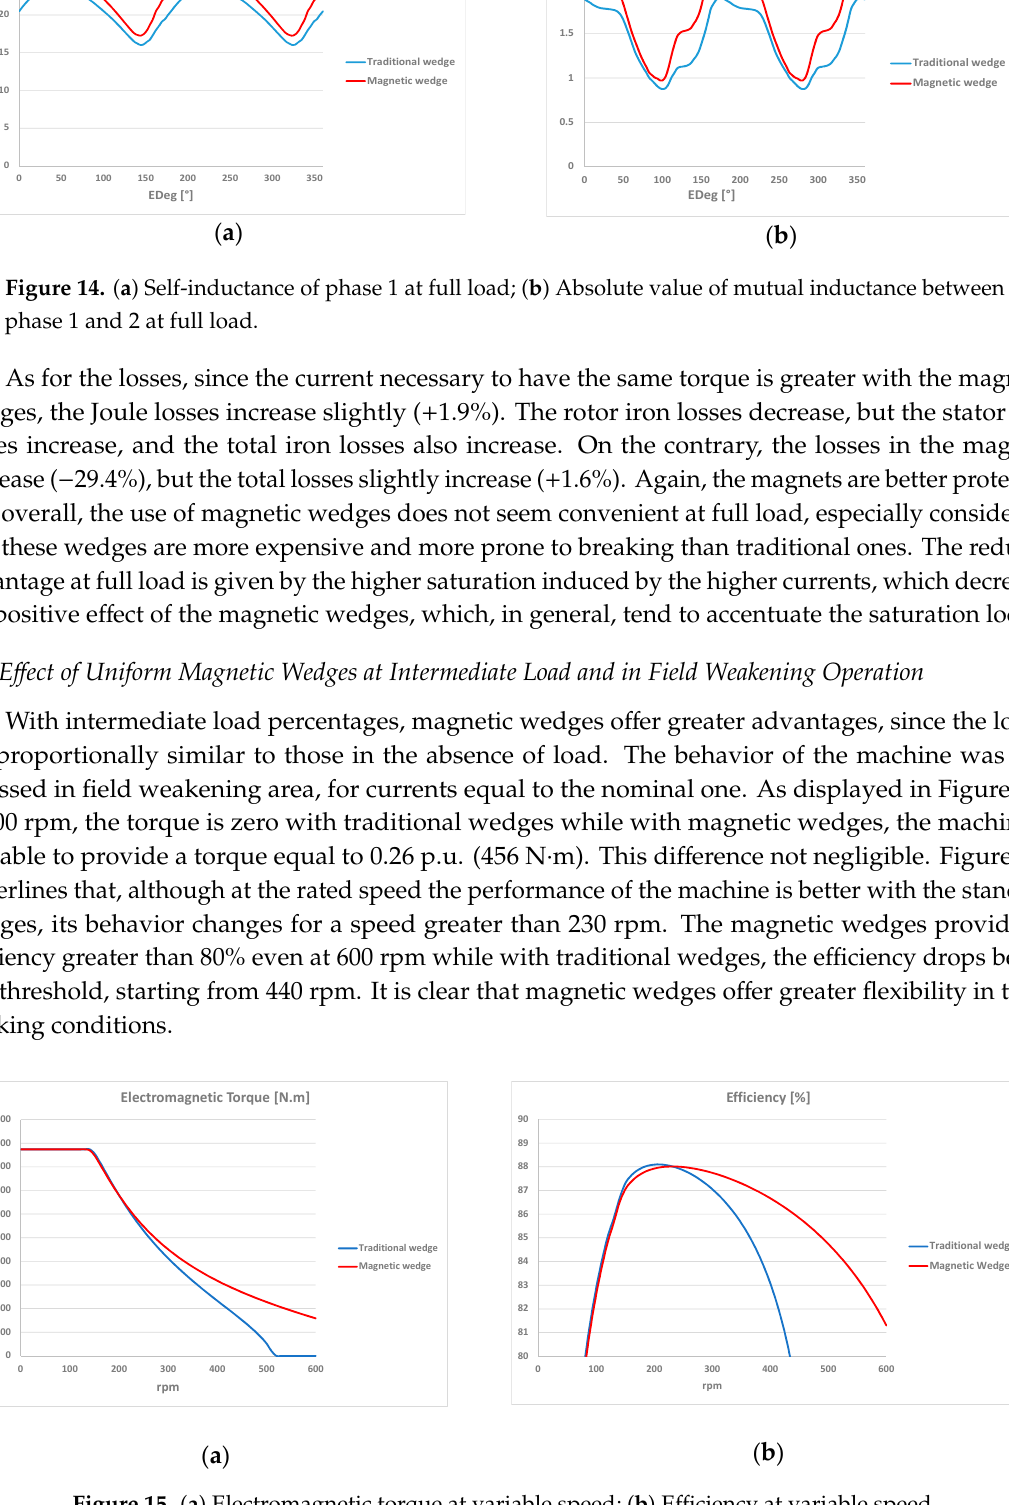
( b ) Figure 13. ( a ) Cogging torque under no load; ( b ) Torque at full load. At full load, the magnetic wedges provide an increase in self-inductance, due to the reduction in the reluctance of the magnetic circuit. Its average value rises by only 10.7%, both for the not very high permeability of the wedge and for the saturation present in some parts of the machine, as in Figure 14a. The mutual inductance also increases, by about 20%, as in Figure 14b, however, its absolute values remain low and do not cause any problem. Due to the saturation phenomena, the fully loaded machine behaves as not perfectly isotropic from the magnetic point of view. The inductance along the d axis increases as well and the flux linkage along the d axis decreases (Table 4).